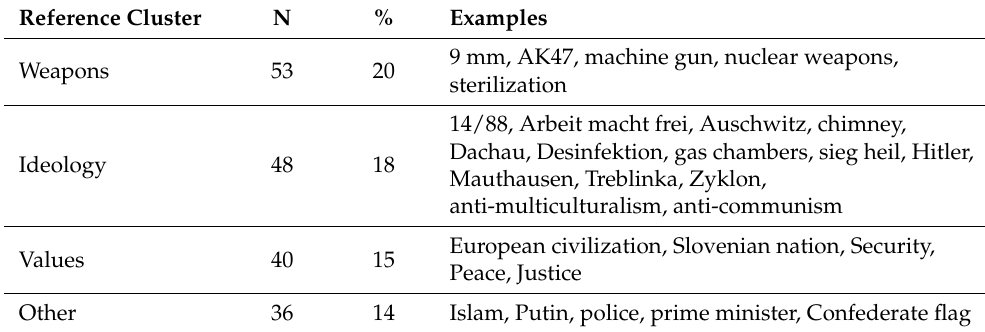
Table 6. Reference: clusters, numbers, shares, and examples of statements (N = 261). Reference Cluster N